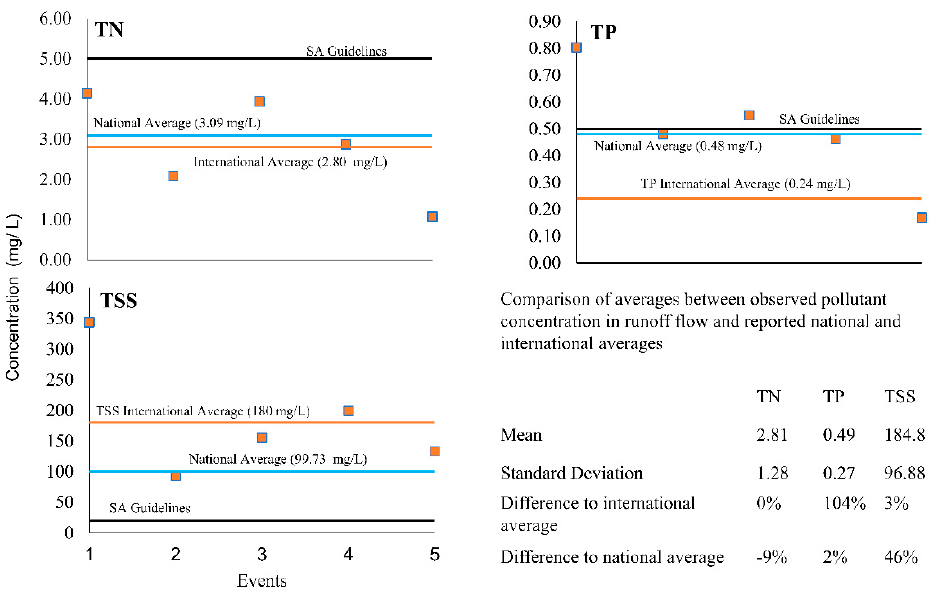
Figure 7. Characterization of stormwater quality of the case study catchment in comparison to national and international mean stormwater quality data.